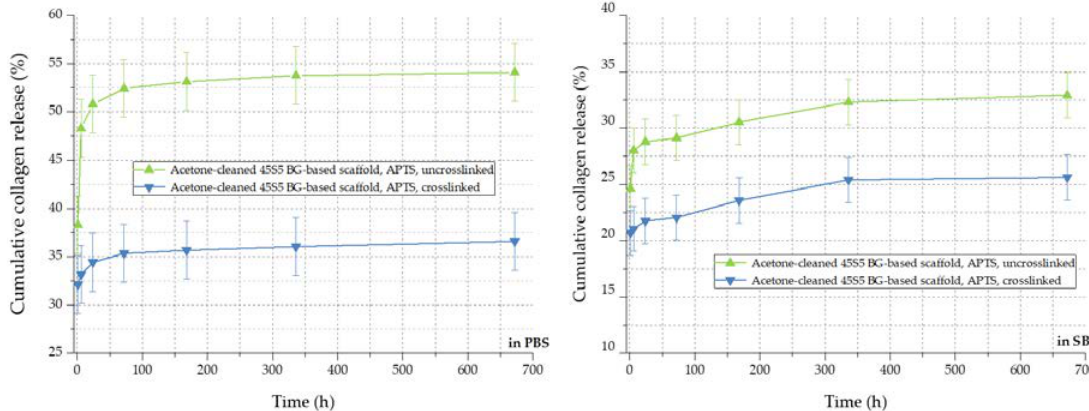
Figure 12. Collagen release kinetics of collagen-coated 45S5 BG-based scaffolds in PBS ( left ) and SBF ( right ) before and after crosslinking.